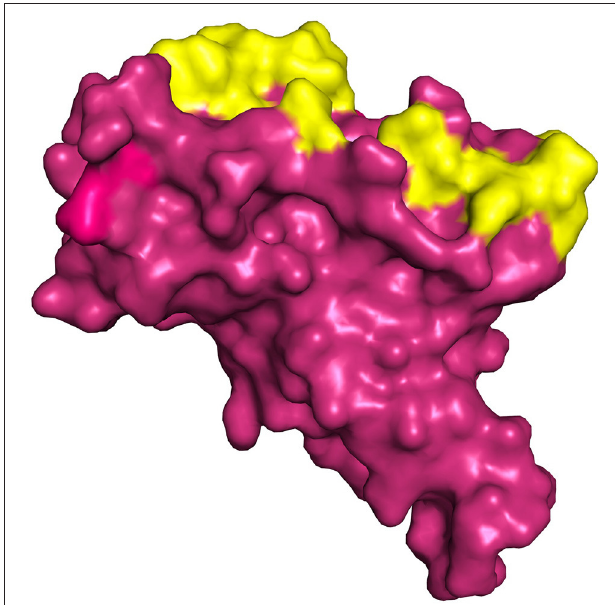
FIGURE 5 | Represents the region of docking grid fixation (yellow surface) based on the documented active site residues and P2RANK prediction including glycosylation site (PDB ID